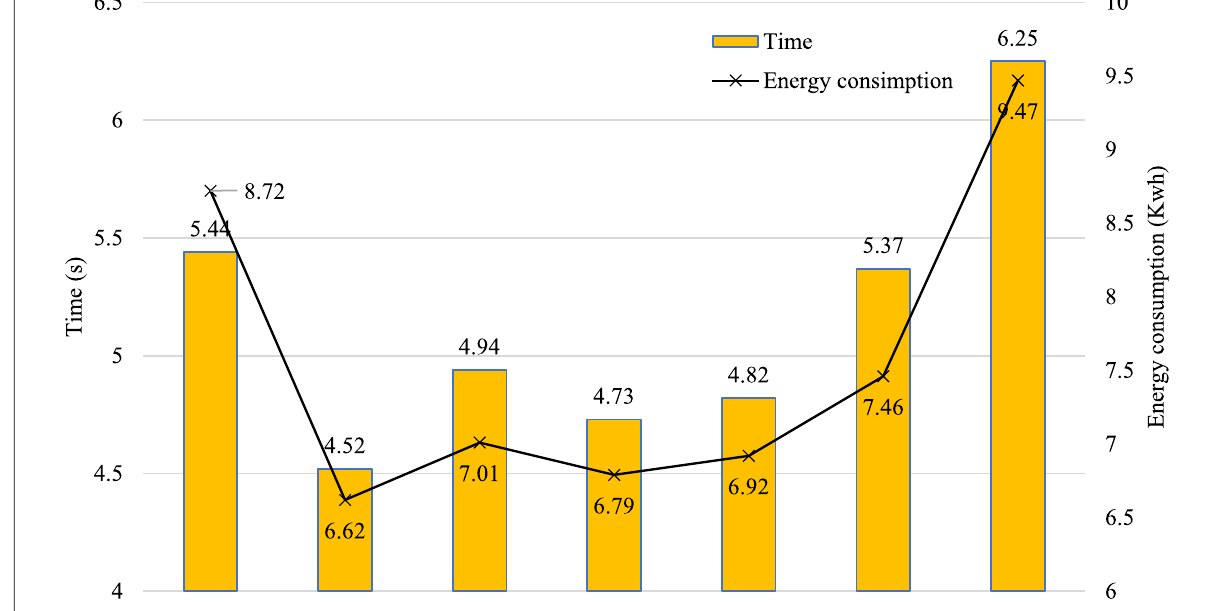
Figure 9 Energy assessment results of machining features